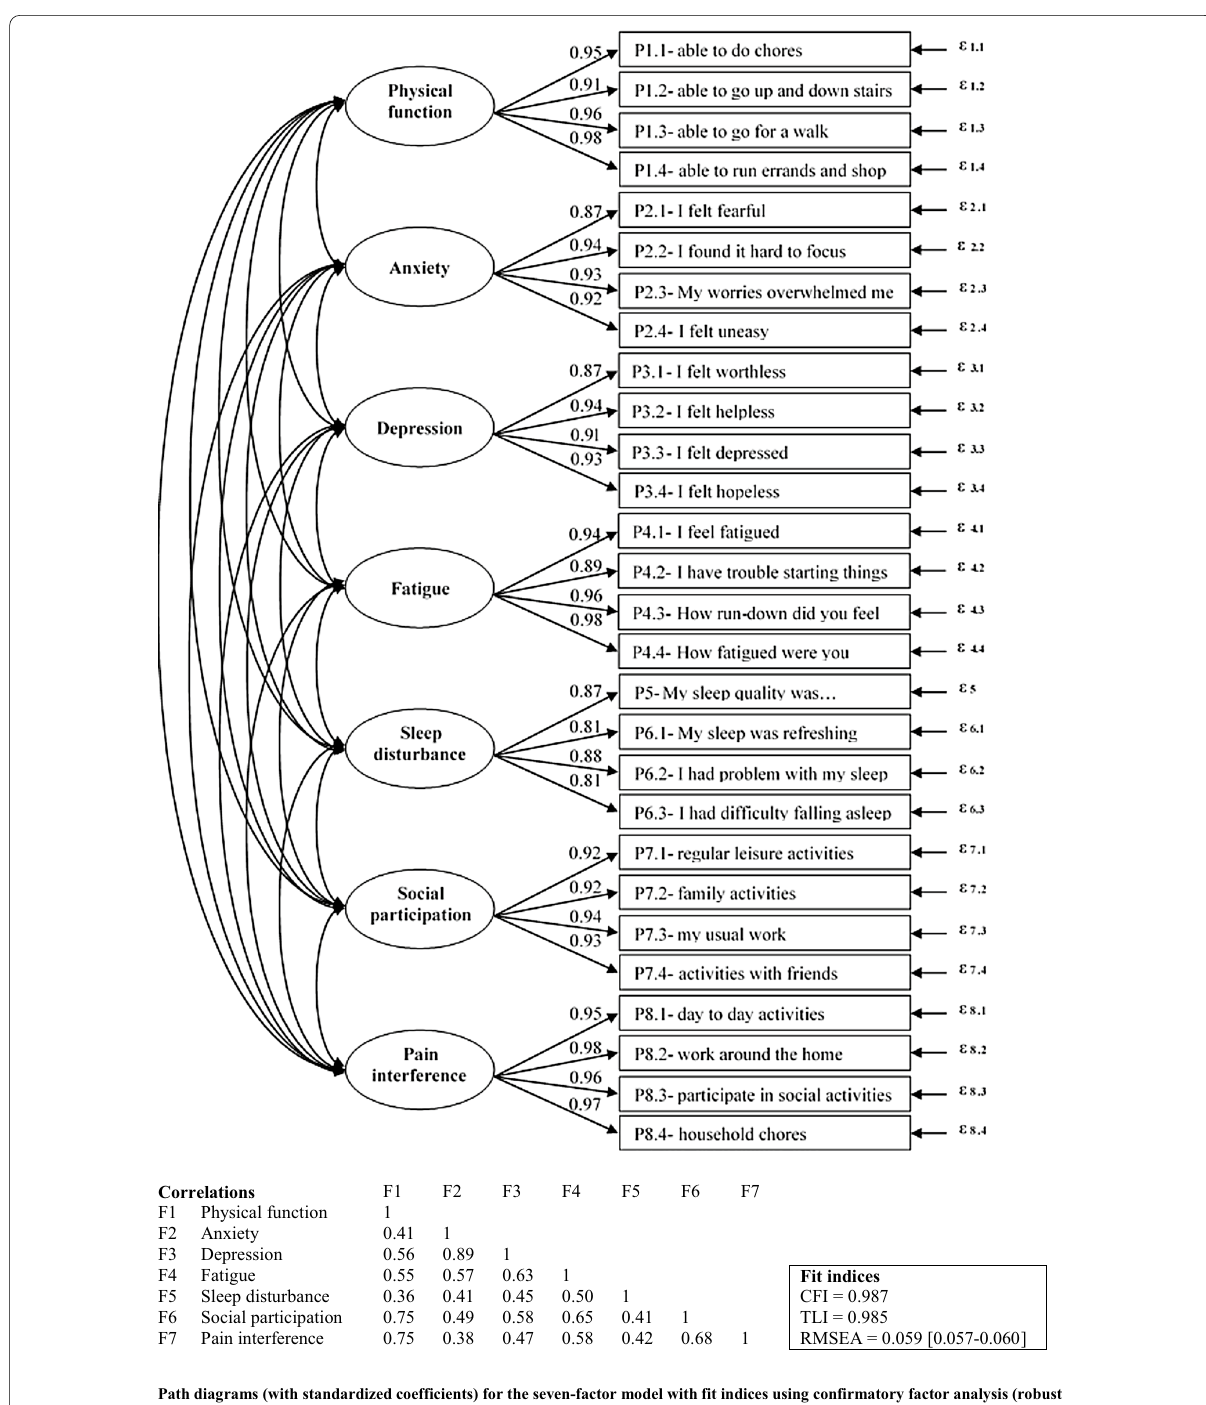
Path diagrams (with standardized coefficients) for the seven-factor model with fit indices using confirmatory factor analysis (robust weighted least squares [WLSMV] estimator). Ellipses represent unobserved latent factors, rectangles represent observed variables, single- headed arrows represent the effect of one variable on another (factor loading) and double-headed arrows represent covariance between pairs of variables. ε: measurement error df: degree of freedom. CFI: Comparative Fit Index. TLI: Tucker Lewis Index. RMSEA: Root Mean Square Error Approximation. The residual variances are not estimated when a WLSMV estimator is used. Fig. 1 Confirmatory factor